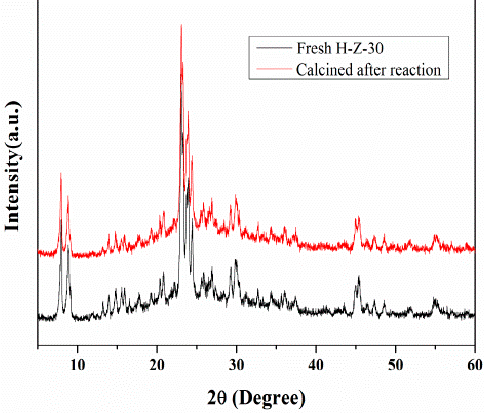
Figure 8. XRD patterns of fresh H-Z-30 and calcined H-Z-30 after the cellulose hydrolysis.